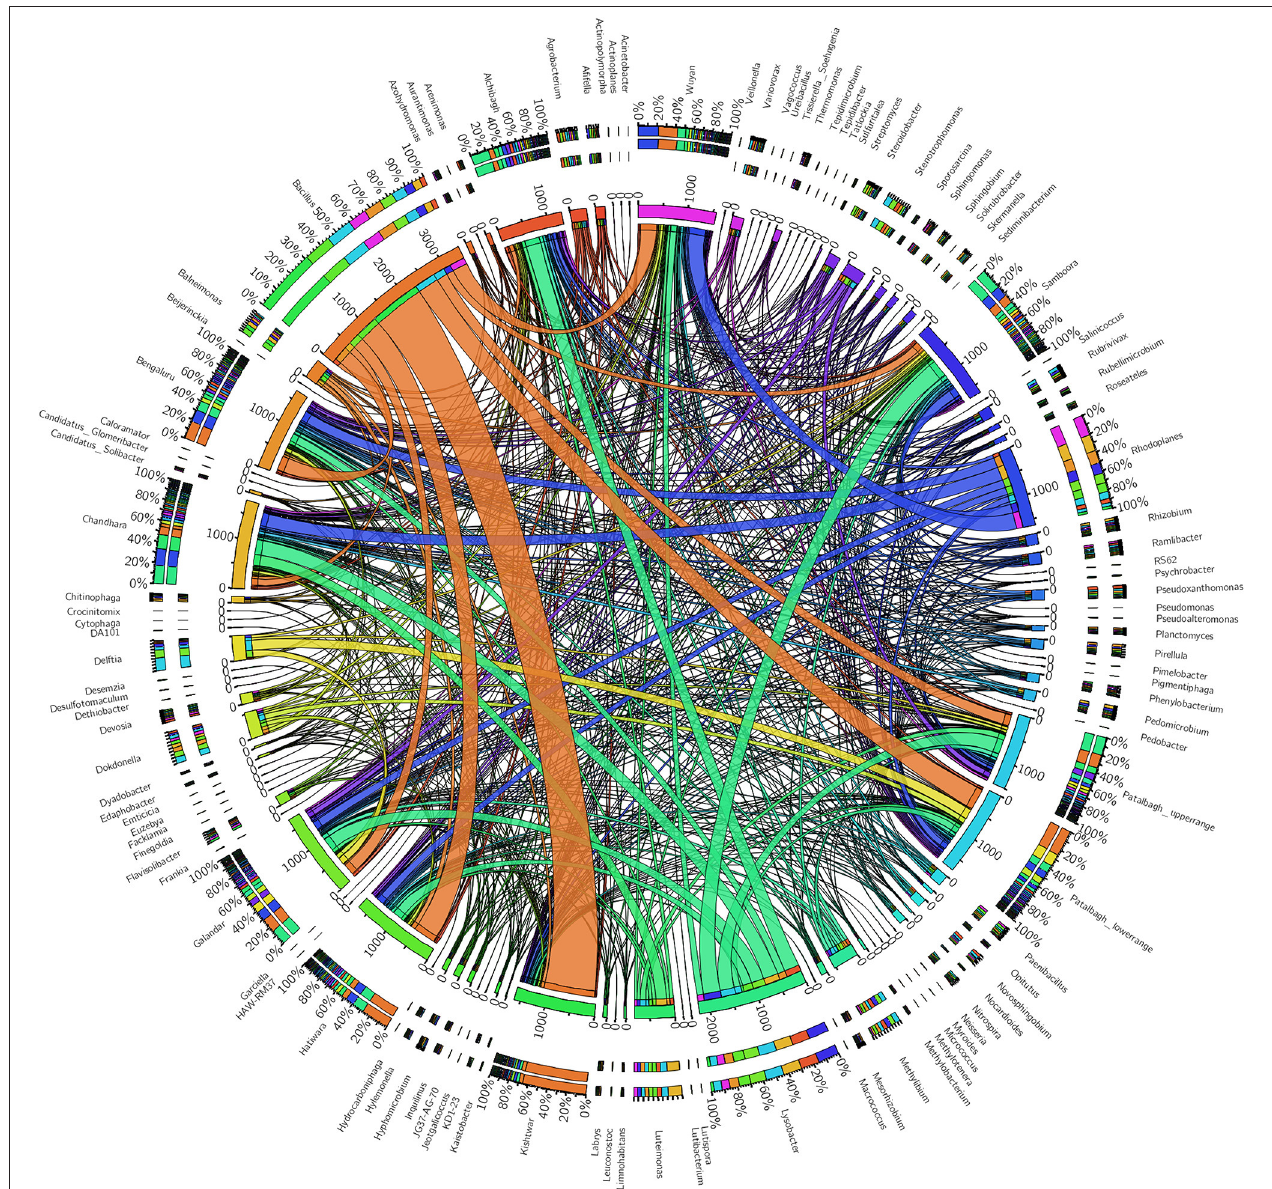
FIGURE 11 | Circos plot representing the core rhizo-bacteriome and unique rhizobacteria in saffron grown across different geographical locations. Central line (ribbons) represents the abundance of each genus and connects genera to samples. The outer three rings are the stacked bars that represent the relative contribution of particular genera in every